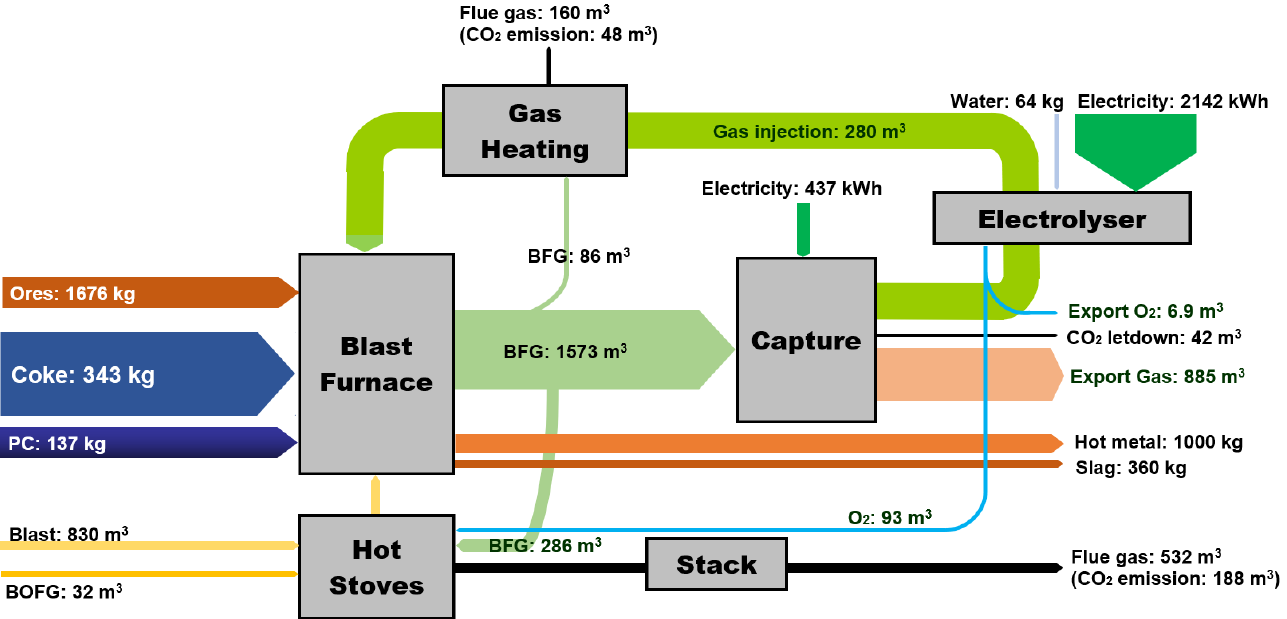
Figure 13. Energy and material consumption of the process with 80 m 3 /tHM hydrogen injection. Relative flow size estimated by energy and demonstrated as bar width.